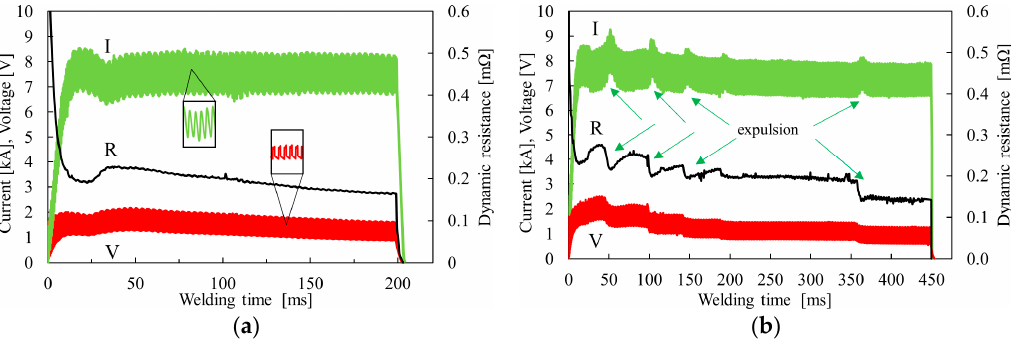
Figure 3. Welding current, electrode voltage and dynamic resistance signals as obtained from runs ( a ) no. 1 and ( b ) no. 4. I and V, real values; R, root mean square (RMS) values.